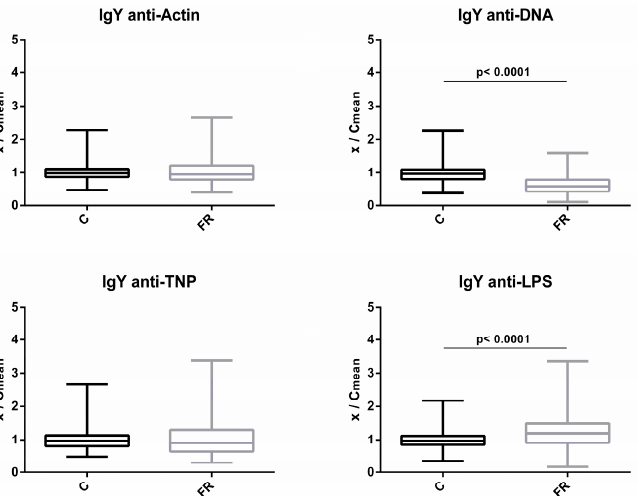
Figure 2. Comparison of IgY NAb levels between fast- and slow-growth broilers: IgY NAb levels were estimated by the binding capacity of serum NAbs to actin, DNA, TNP and LPS. On the y axis, values are given as a ratio of individual NAb levels relative to the mean NAb levels of the control group (y =